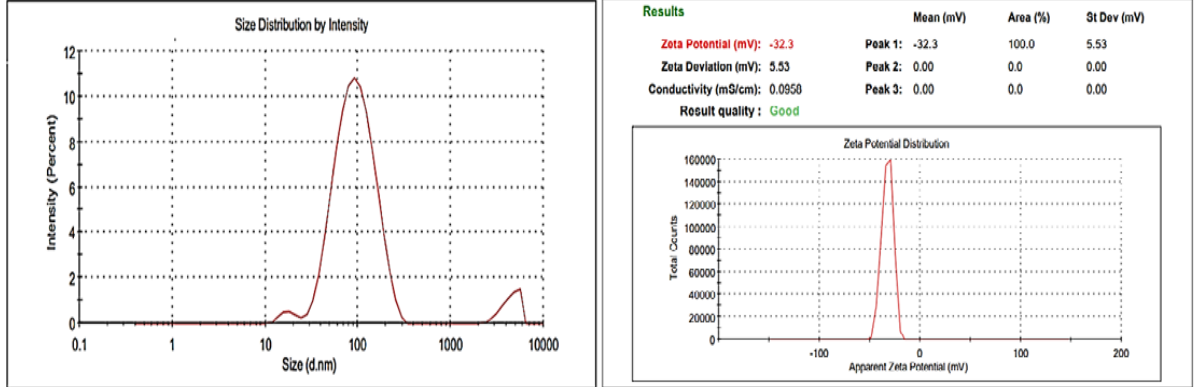
Figure 6. Particle size, PDI and Zeta potential measurement of optimized nanoformulation.